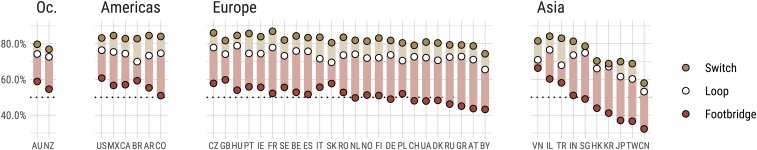
Percentage choosing to sacrifice in each scenario variant. In all of these countries, participants were most likely to sacrifice in Switch, then in Loop, then in Footbridge. Within each continent, countries are ordered by decreasing order of the average acceptability of sacrifice in the three scenarios. Oc., Oceania. AU: Australia, NZ: New Zealand, US: United States of America, MX: Mexico, CA: Canada, BR: Brazil, AR: Argentina, CO: Colombia, CZ: Czechia, GB: United Kingdom of Great Britain and Northern Ireland, HU: Hungary, PT: Portugal, IE: Ireland, FR: France, SE: Sweden, BE: Belgium, ES: Spain, IT: Italy, SK: Slovakia, RO: Romania, NL: Netherlands, NO: Norway, FI: Finland, DE: Germany, PL: Poland, CH: Switzerland, UA: Ukraine, DK: Denmark, RU: Russian Federation, GR: Greece, AT: Austria, BY: Belarus, VN: Viet Nam, IL: Israel, TR: Turkey, IN: India, SG: Singapore, HK: Hong Kong, KR: The Republic of Korea, JP: Japan, TW: Taiwan (Province of China), CN: China.